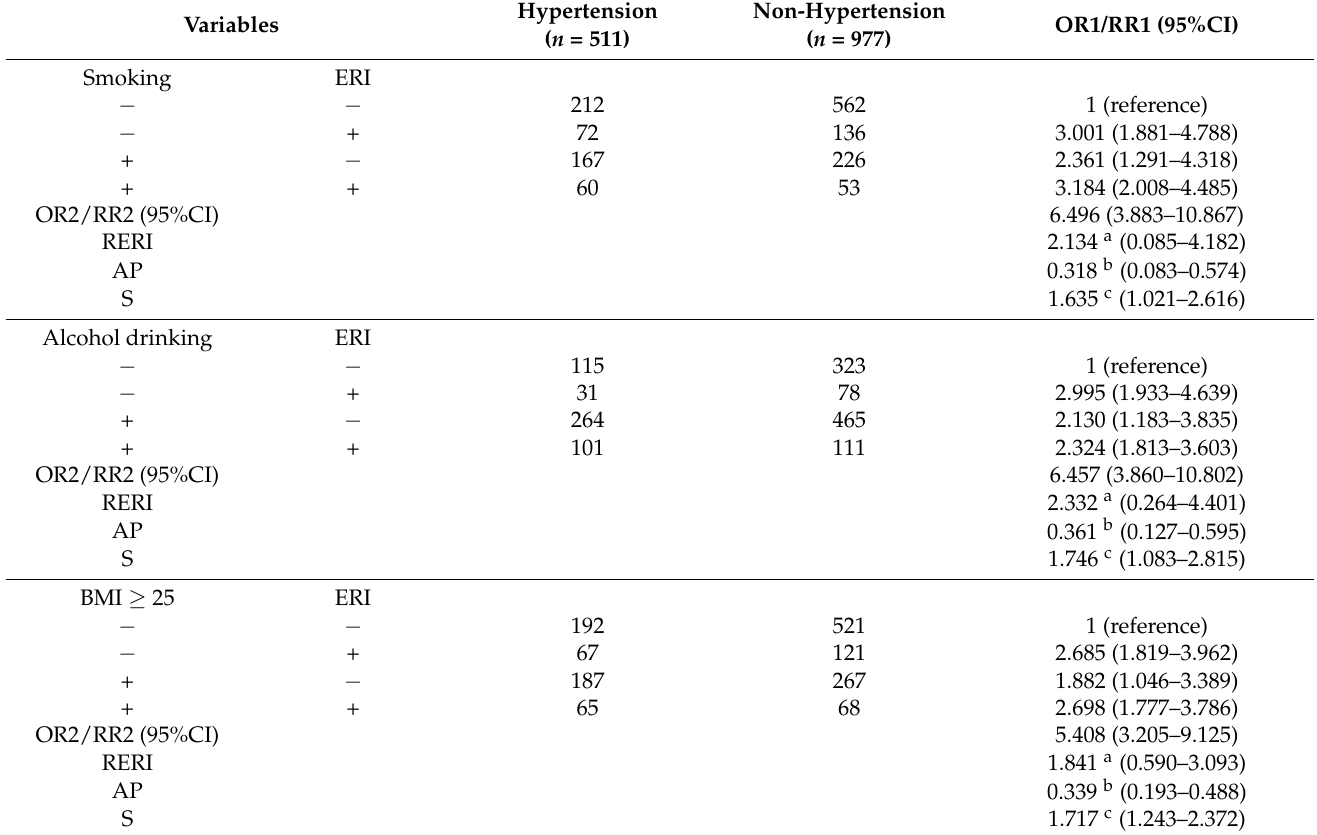
Table 3. Analysis of interaction between occupational stress and risk factors on